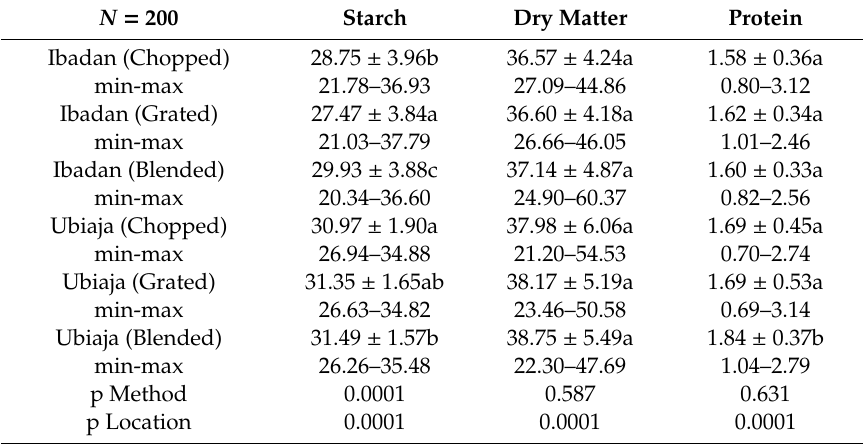
Table 1. Showing Starch, Dry matter, and Protein content (%) of yam (D. rotundata ). N = 200